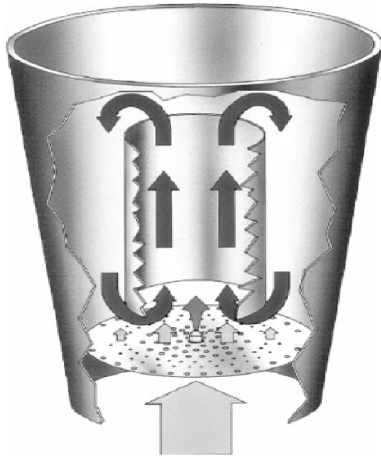
Figure 1. Diagram of bottom spray fluidized agglomerator (reprinted with permission from Glatt).